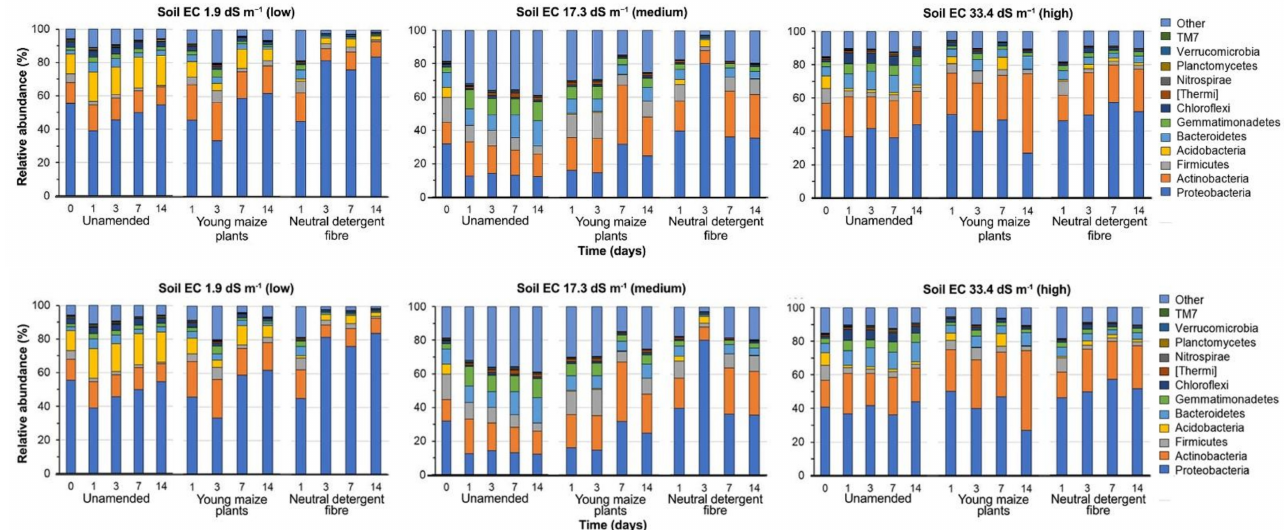
Figure 1. Changes in the relative abundance (%) of bacterial phyla in the three soils from the former lake Texcoco with different electrolytic conductivity (EC) left unamended or amended with young maize plants or their neutral detergent fiber (NDF) fraction at the onset of the experiment (0) and incubated aerobically at 22 ± 2 ◦ C for one (1), three (3), seven (7), or 14 days